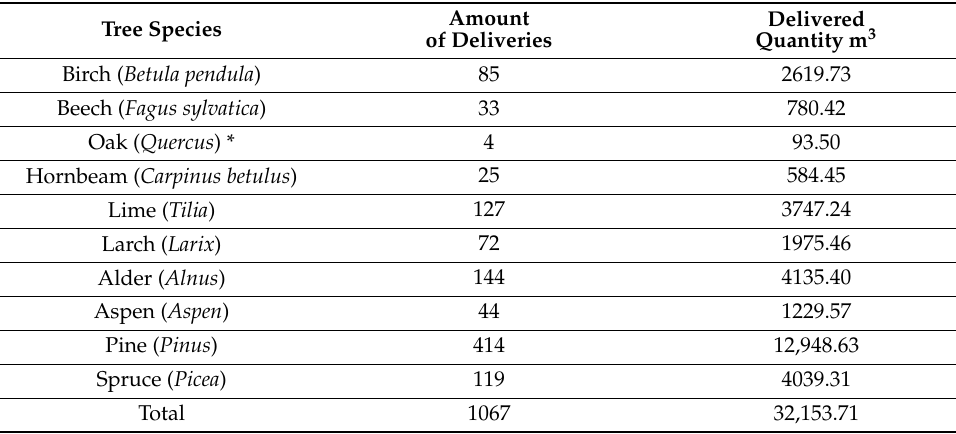
Table 1. Volume and amount of S2 wood deliveries by tree